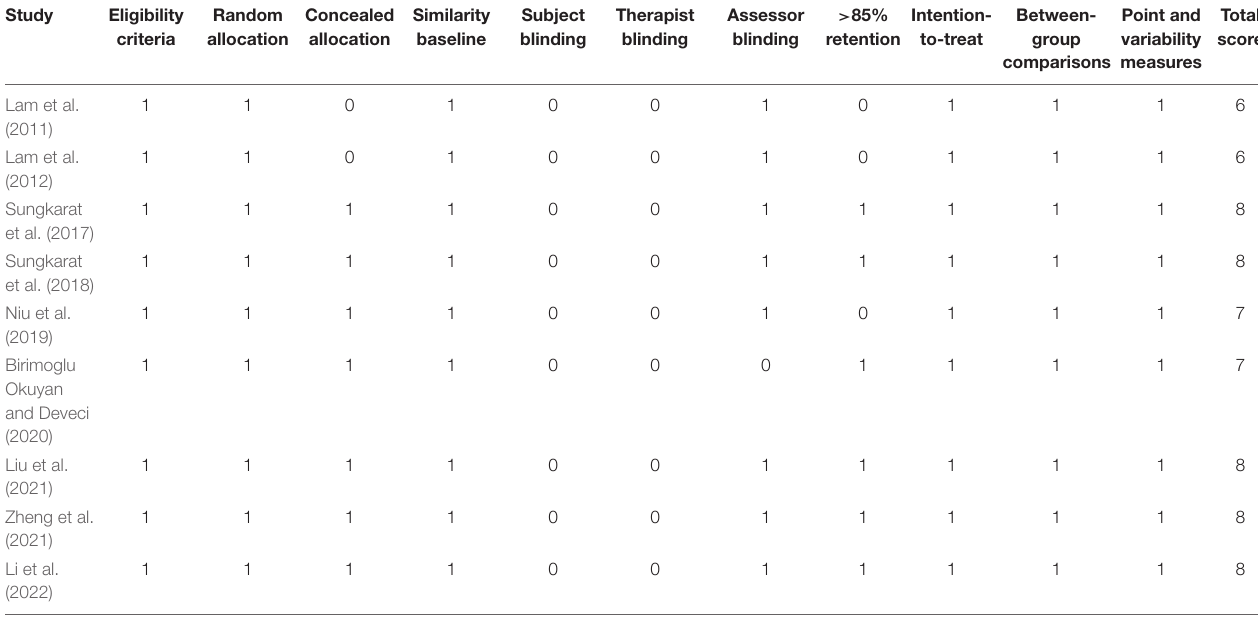
TABLE 2 | Quality assessment of included studies ( n = 9).